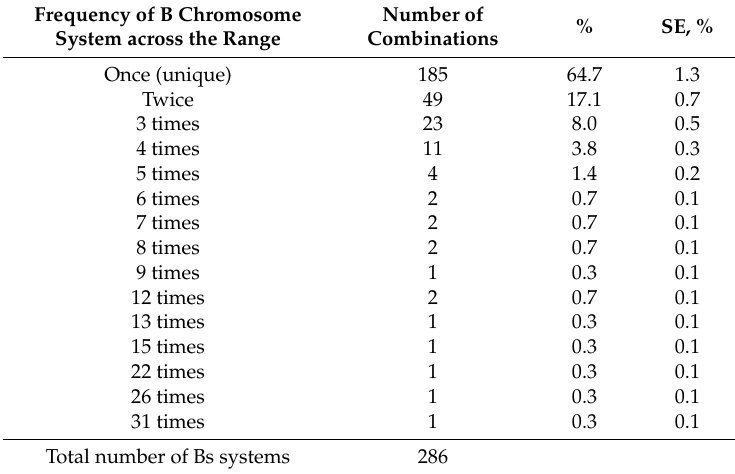
Table 5. The number and ratio of B chromosome systems among A. peninsulae karyotypes across the species